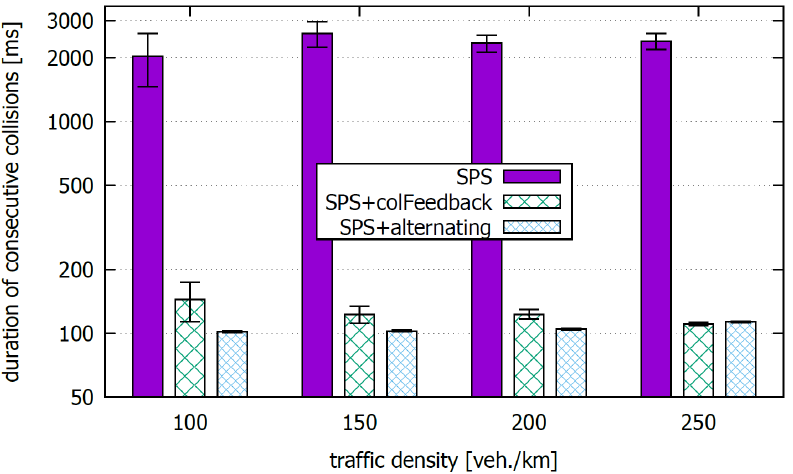
Figure 8. Average consecutive packet collision duration; 95% confidence interval, y-axis in log scale.